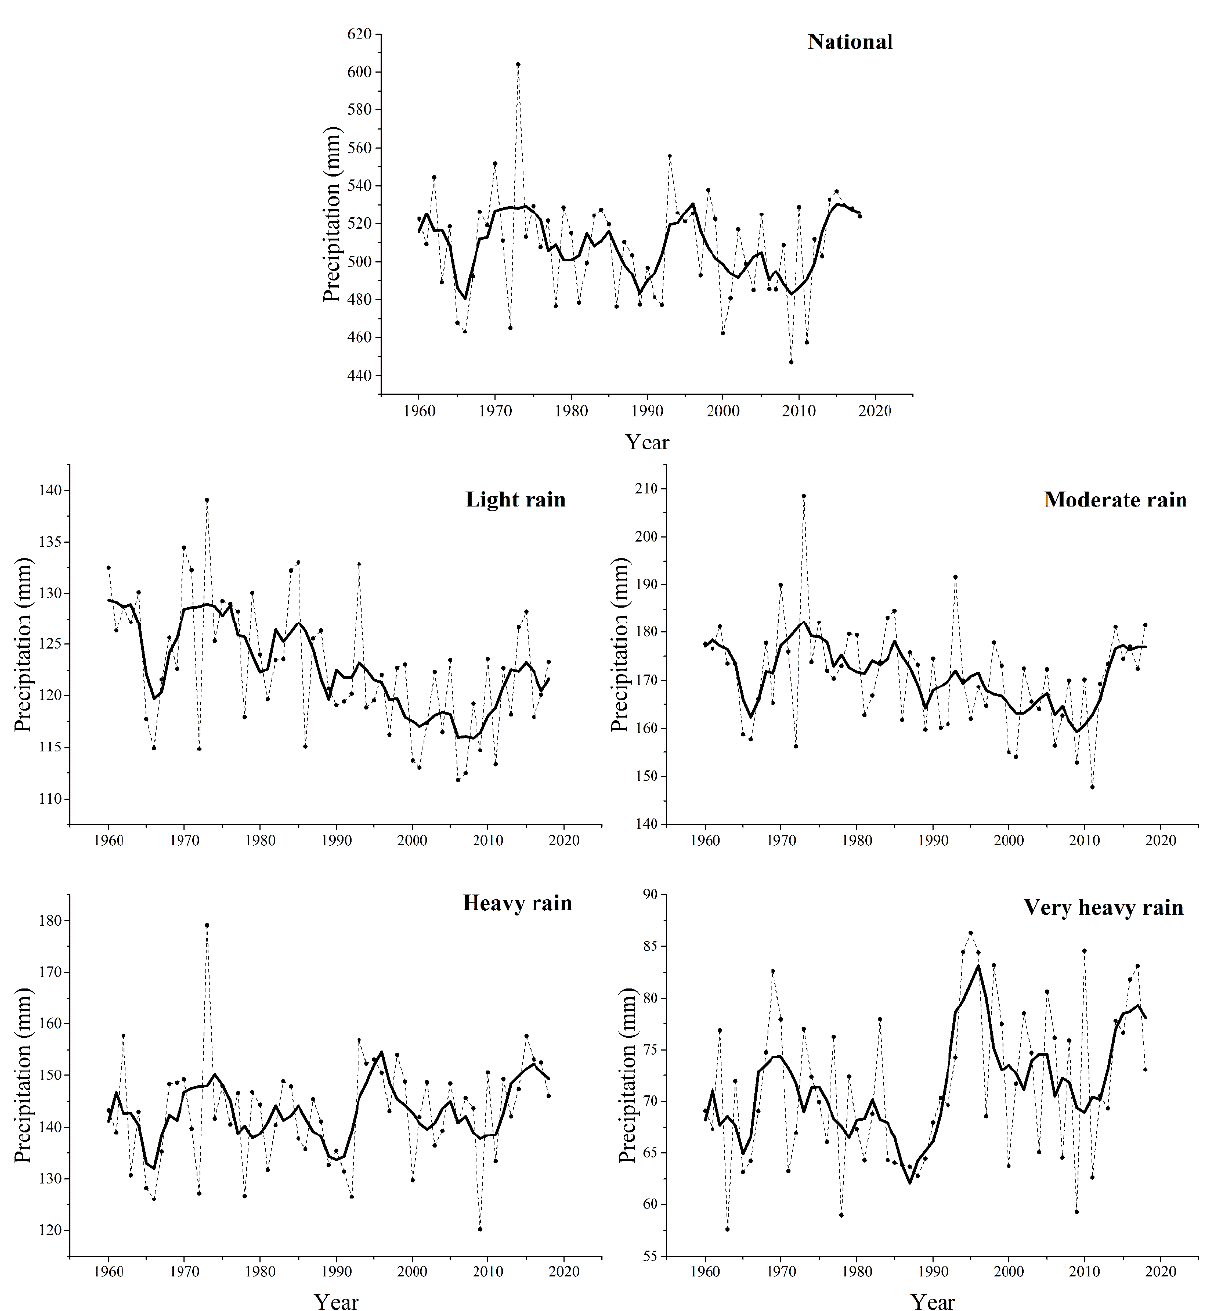
Figure 6. National annual series for precipitation amount during the rainy season in China: total rain-season precipitation, light precipitation, moderate precipitation, heavy precipitation, and very heavy precipitation. The solid line is the result of smoothing with a 9-year binomial filter with reflect ends. The dotted line is national series for precipitation grade.